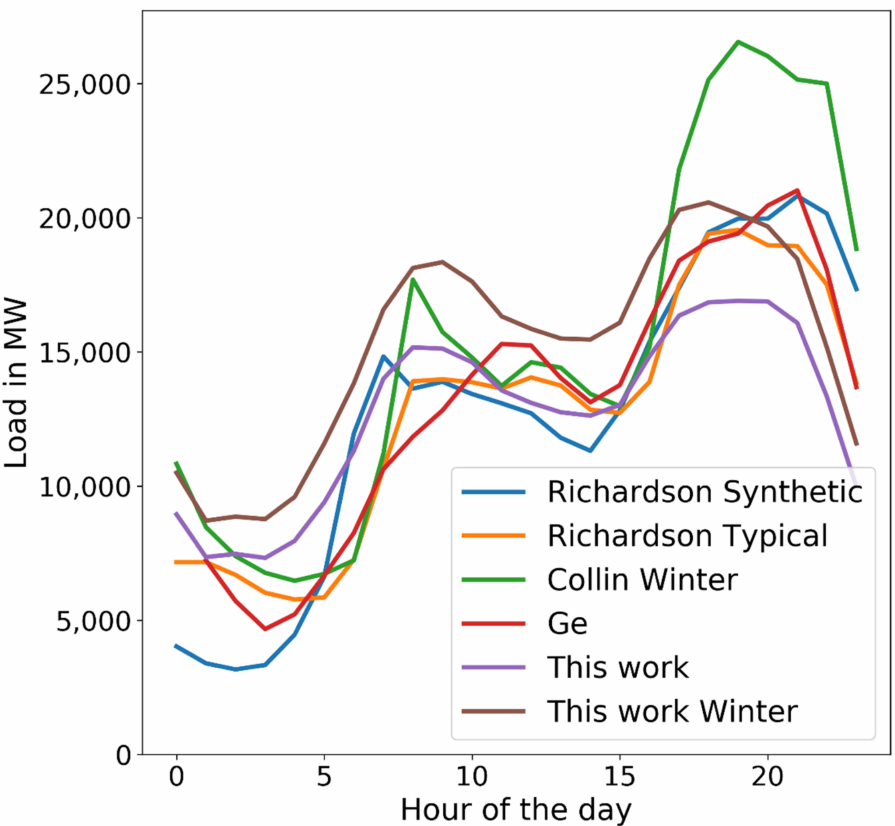
Figure A9. Comparison of the daily average load curve in the United Kingdom between this work and data reproduced from [9], Collin et al.: 2012, [4], Richardson et al.: 2010 and [15], Ge et al.: 2016. Collin Winter and This work Winter only show the load curve during winter months and are scaled to the same average consumption. All other profiles are scaled to the same average annual consumption. Richardson Synthetic does not contain thermal loads. The X-axis shows local time.